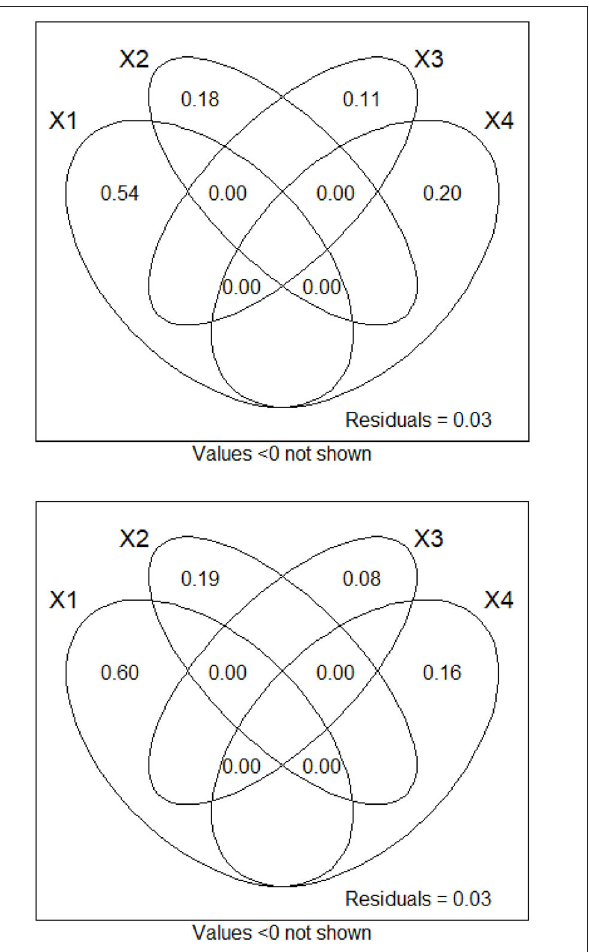
FIGURE 5 | Variation partition diagram of hourly chlorophyll a and phycocyanin flurorometry between the three sets of dbMEM variables, as divided into ecologically interesting groups. See text for variable group explanations and